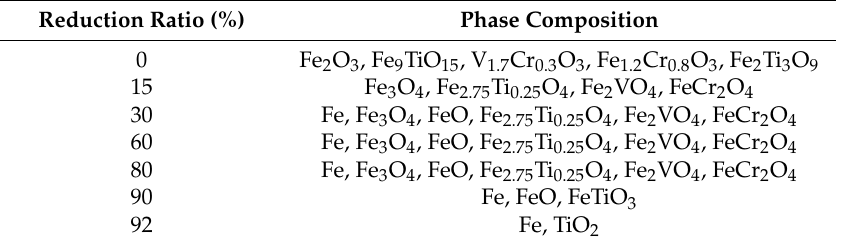
Table 3. Phase compositions of the HCVTM pellets at different reduction